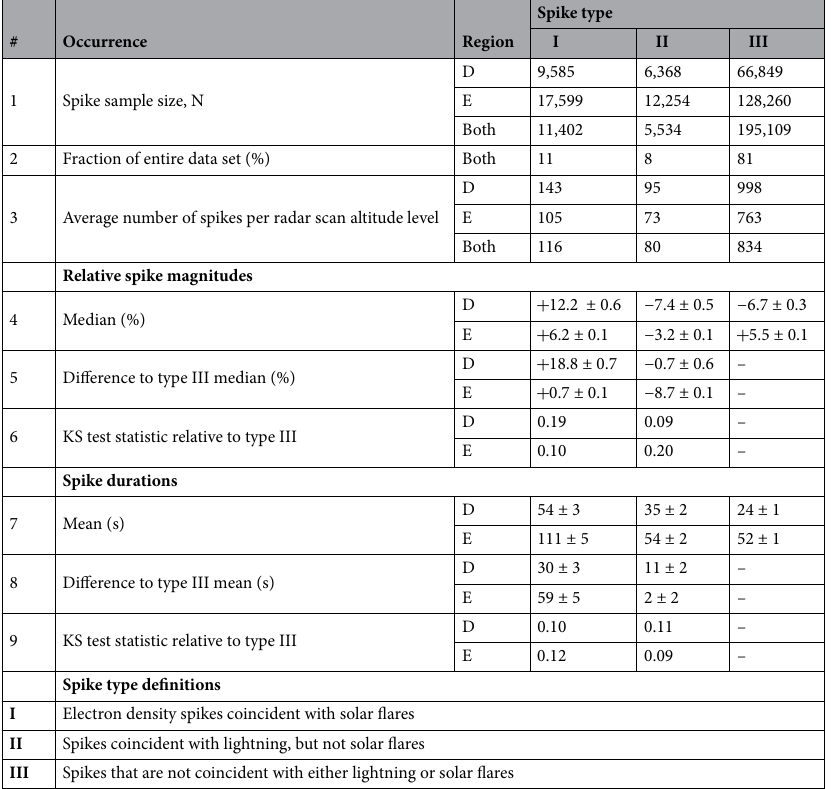
Table 1. Summary properties of sudden electron density changes (or